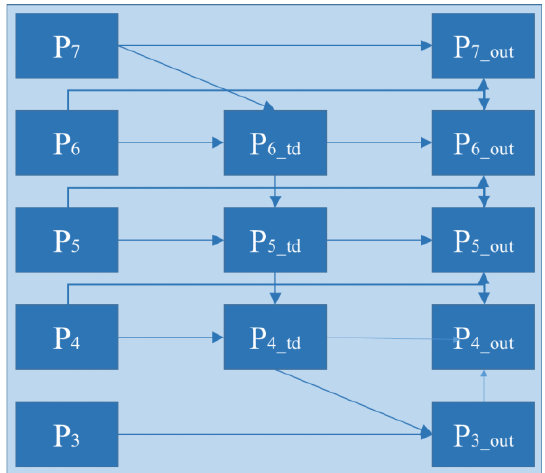
Figure 9. Bi-FPN structure for multi-scale feature fusion.